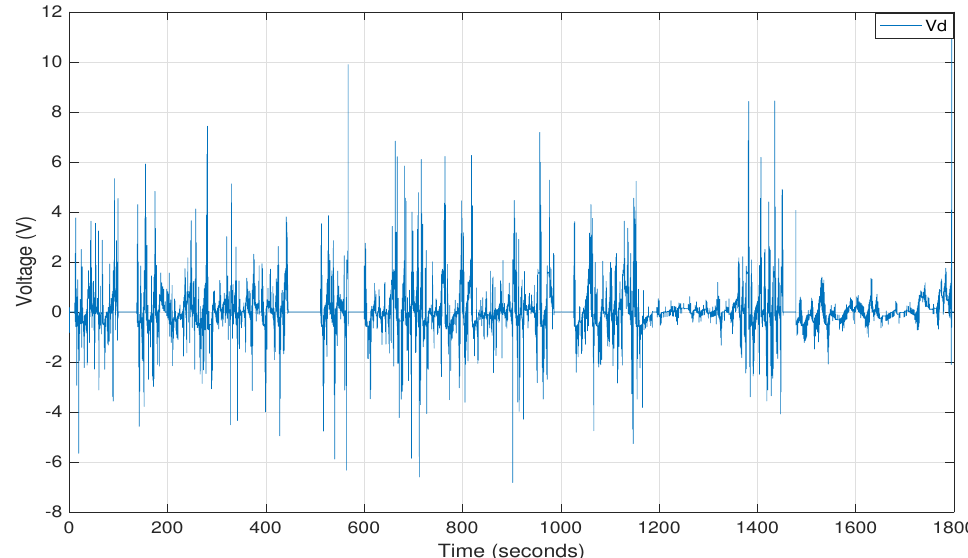
Figure 8. Real-time stator voltage v d obtained from electrified